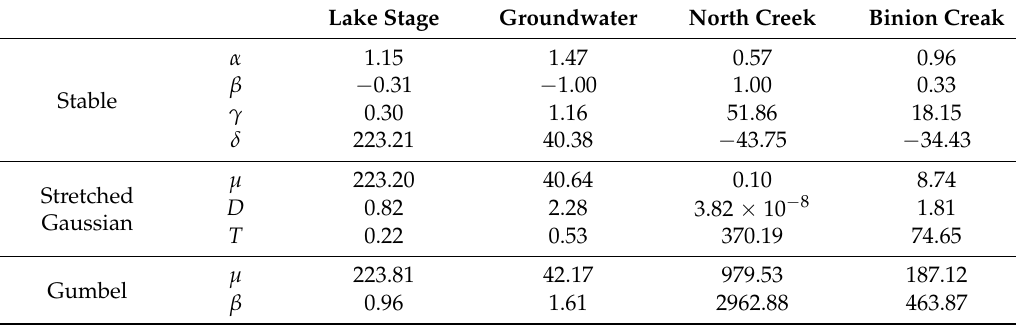
Table 4. The distribution parameters for the water measurement distribution fittings.